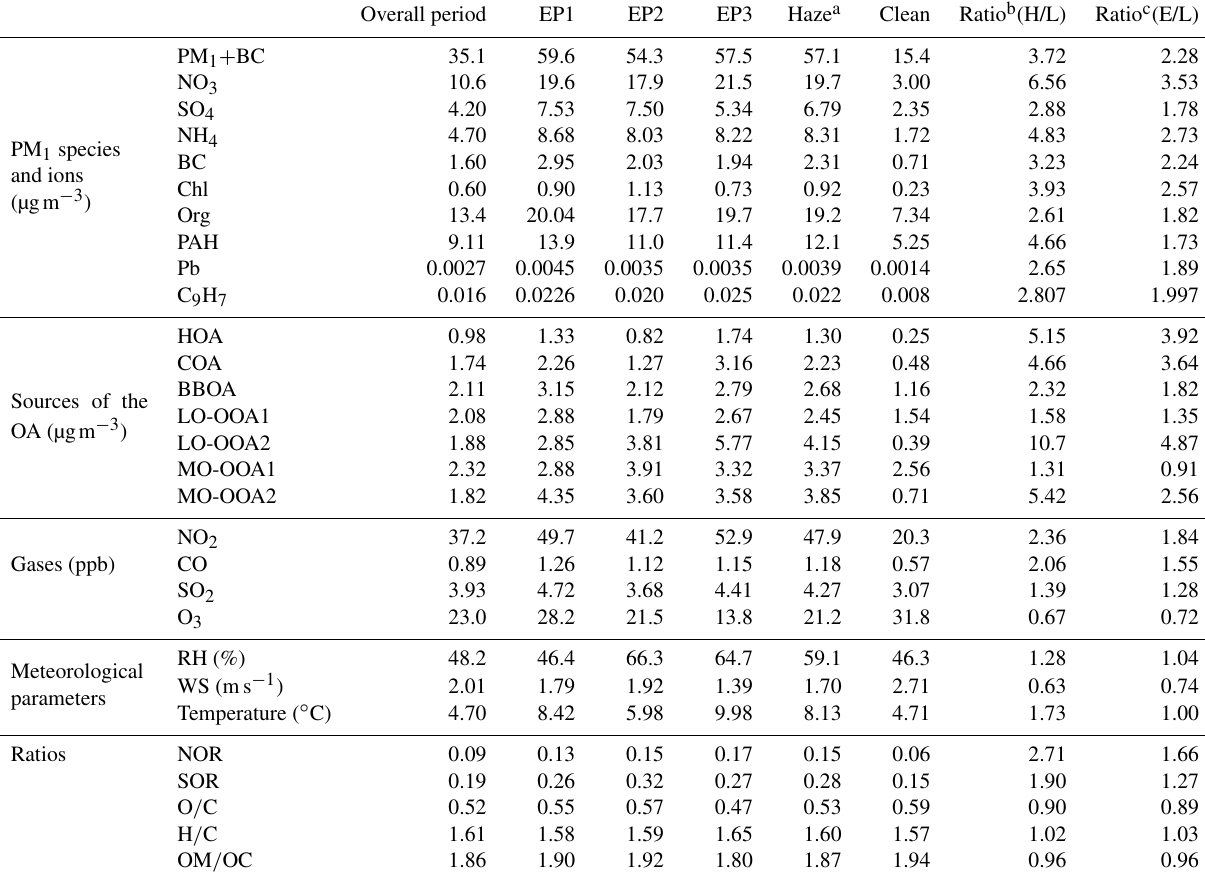
Table 2. Comparison of the aerosol properties and meteorological parameters between the high- and low-loading periods. Overall period EP1 EP2 EP3 Haze a Clean Ratio b (H/L) Ratio c (E/L)